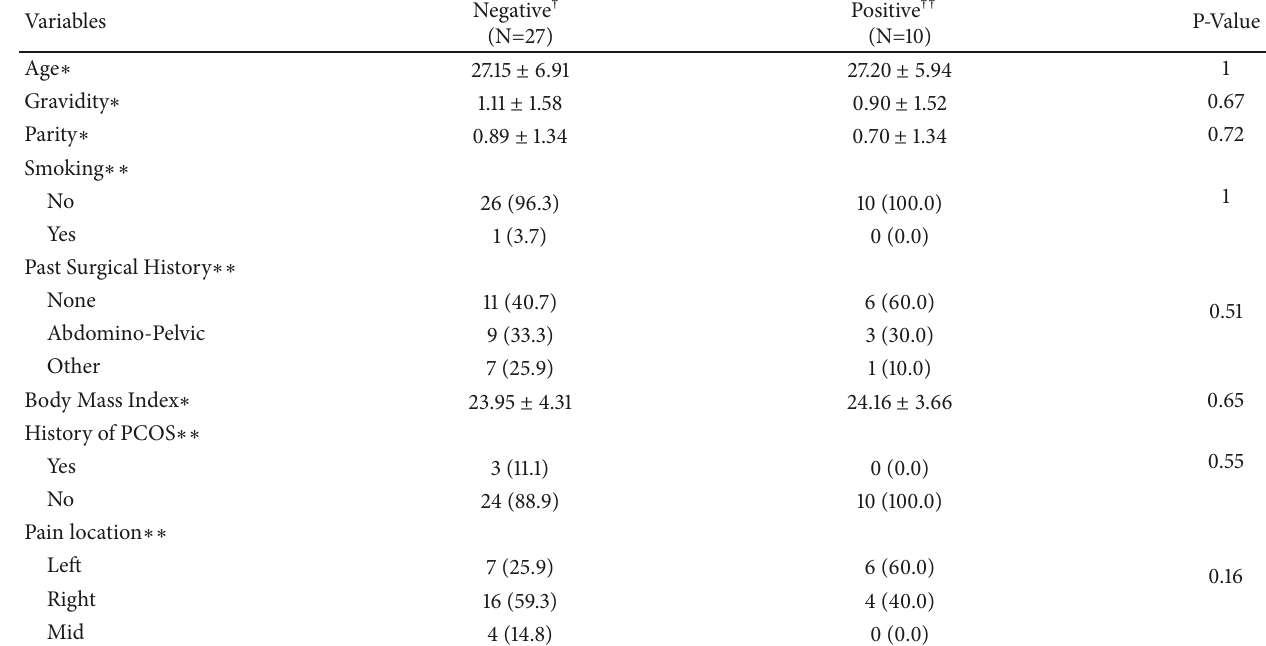
Table 2: Patient characteristics in the two patient groups.